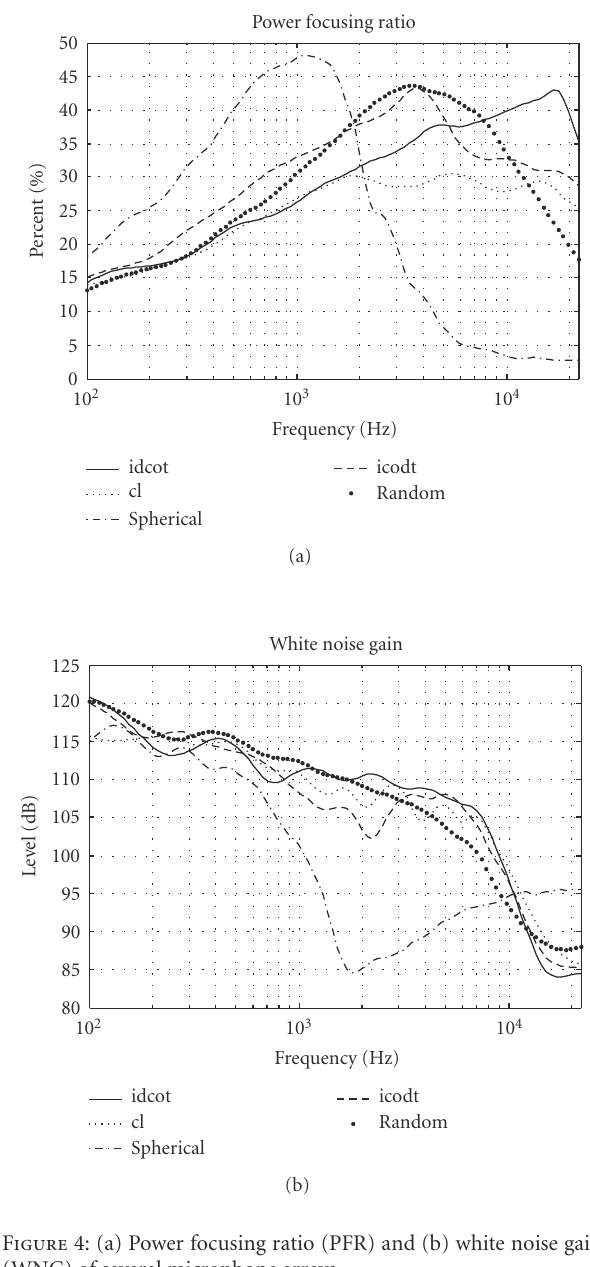
Figure 4: (a) Power focusing ratio (PFR) and (b) white noise gain (WNG) of several microphone